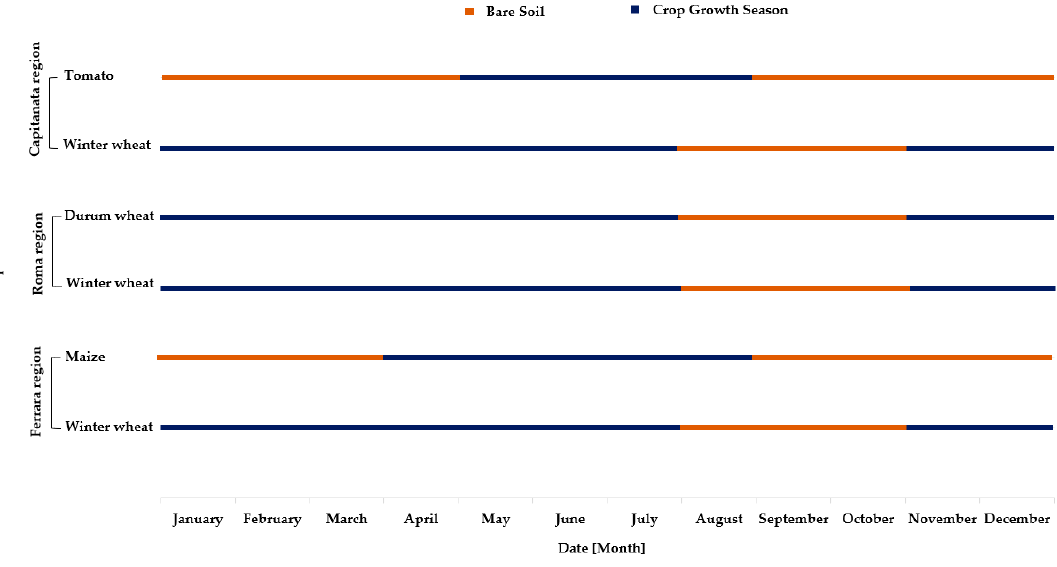
Figure 10. A summary figure of the bare soil frequency, crop management and growth cycle throughout the monthly average of the four years for each region.